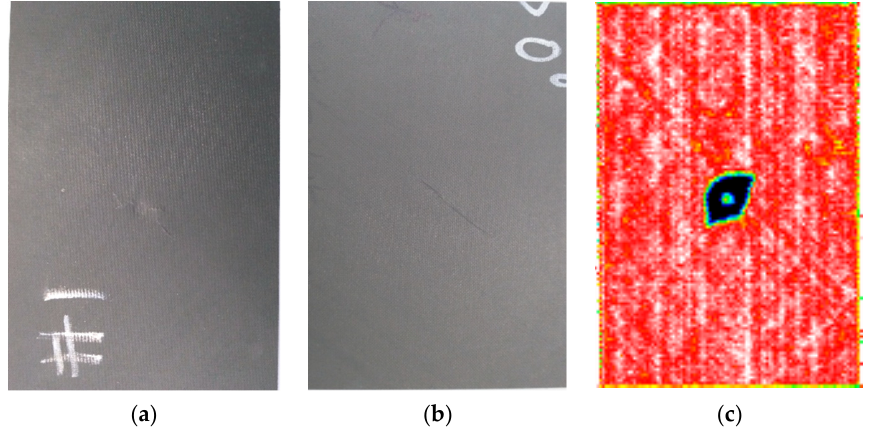
Figure 1. Devices for the CAI test. ( a ) Impact test device. ( b ) Compression test device.